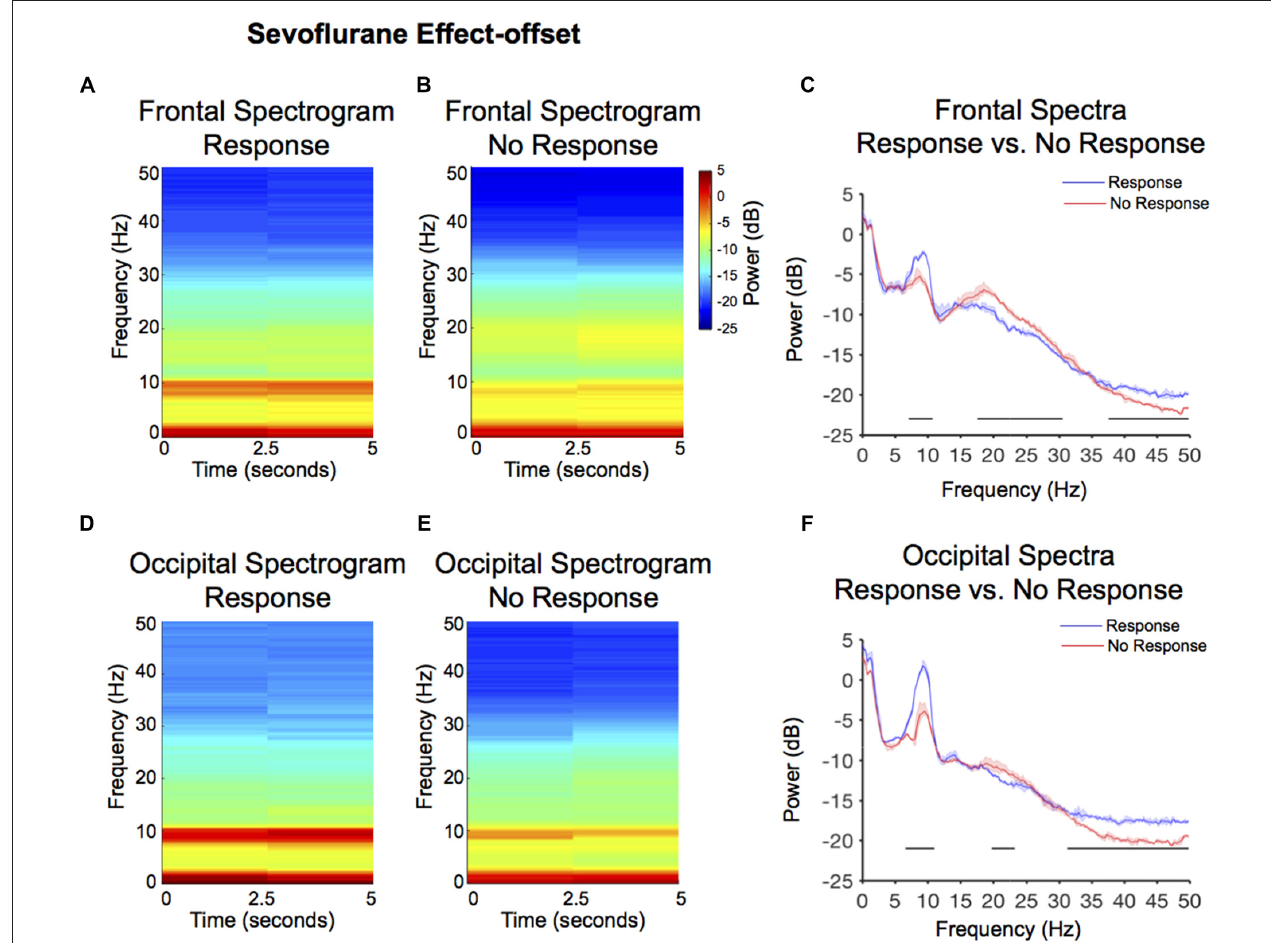
FIGURE 4 | Spectral comparison of response vs. no-response curves during anesthesia effect-offset. (A,B) Median frontal spectrograms of response and no-response ( n = 8). (C) Overlay of median response frontal spectrum (blue), and median no-response frontal spectrum (red). Bootstrapped median spectra are presented, and the shaded regions represent the 99% confidence interval for the uncertainty around each median spectrum. We observed differences in power among frequency bands within response and no-response spectra ( Table 1 ). Black lines represent statistically significant frequencies. (D,E) Median occipital spectrograms of response and no-response ( n = 8). (F) Overlay of median response occipital spectrum (blue), and median no-response occipital spectrum (red), with shaded regions showing the 99% confidence interval for uncertainty around each bootstrapped median spectrum. We observed differences in power among frequency bands within response and no-response spectra ( Table 1 ). Black lines represent statistically significant